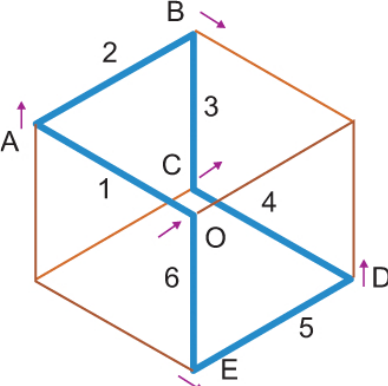
Figure 5. The typical cubical arrangement of the Bricard mecha- nism. The arrows indicate the axes of rotations of revolute joints. When going around the curve in Fig. 6 the mechanism becomes an equilateral triangle at one point.